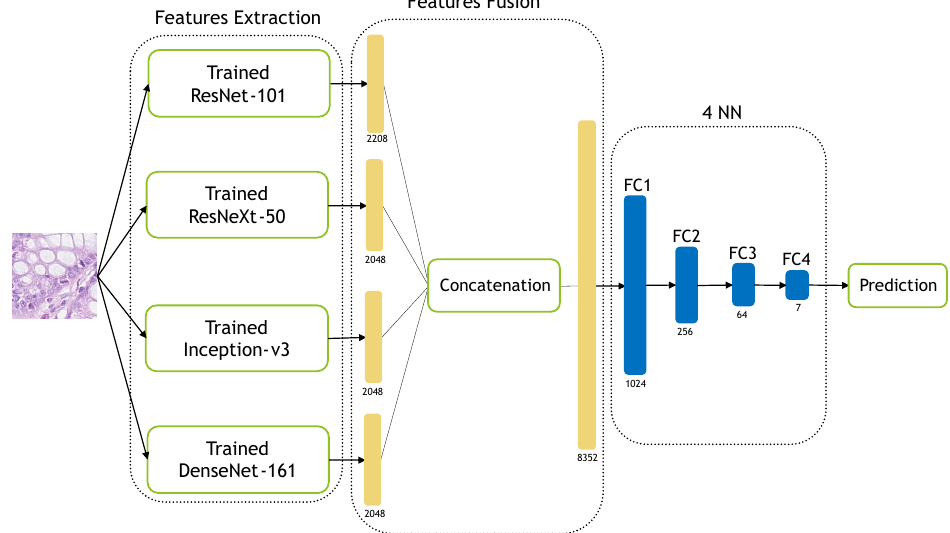
Figure 13. The proposed NN-Ensemble-CNN